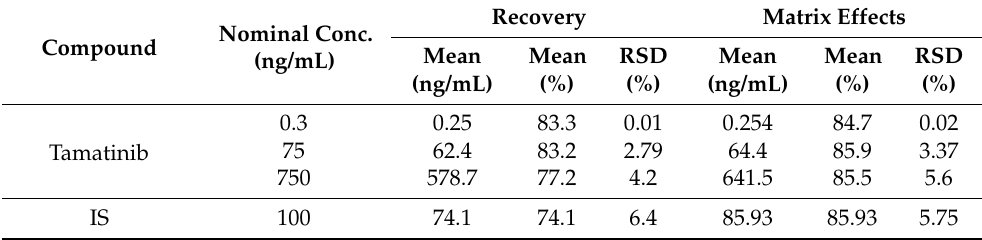
Table 3. Recovery (%) and Matrix Effects for Tamatinib and Internal Standard.